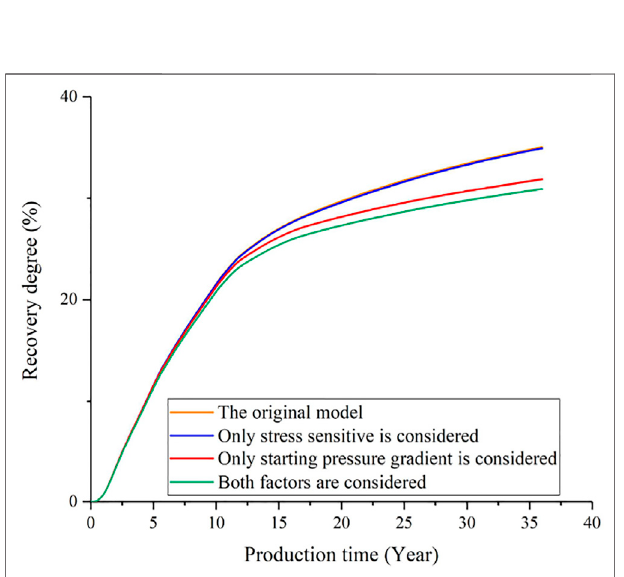
FIGURE 13 | Daily oil production of the Chang 6 reservoir considering different